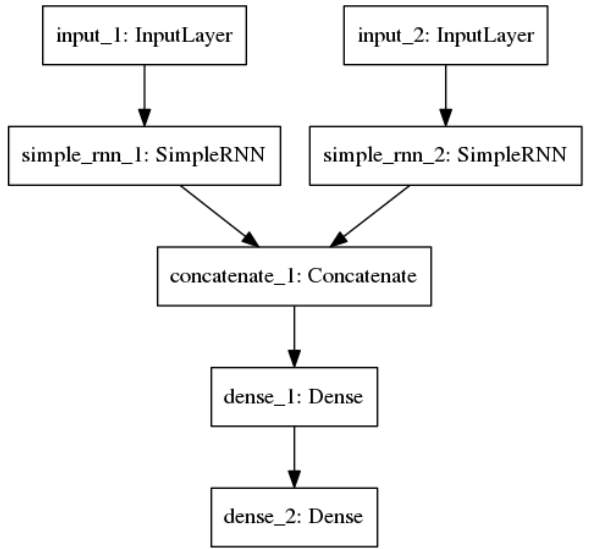
Figure 4. The multi-input recurrent neural network (RNN) architecture with one-hot encoded inputs.